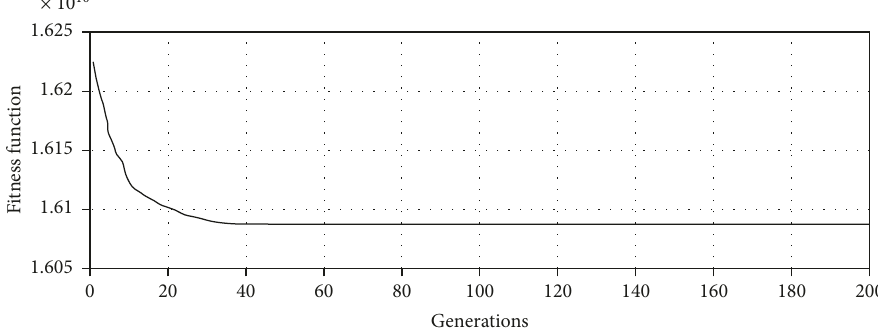
Figure 15: Evolution of the unconstrained fi tness function through generations.